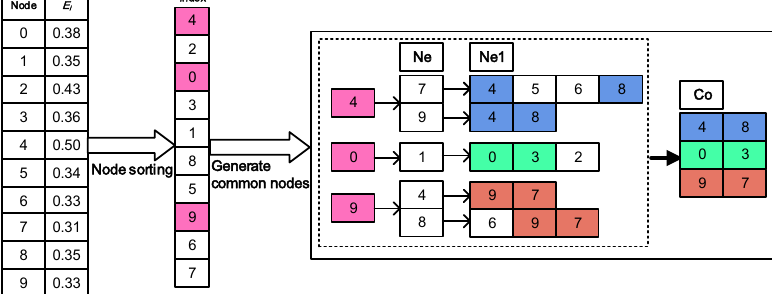
Figure 4. The fast sorting phase. Ne (Ne1) represents the neighbor nodes of the previous nodes. Co represents the neighbor nodes shared by the previous nodes.